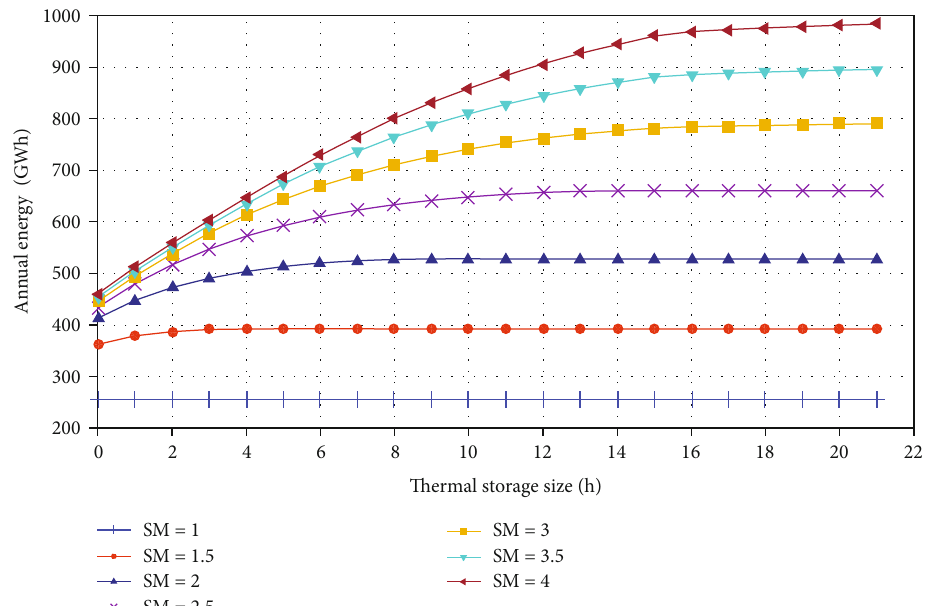
Figure 6: Variation of annual energy with thermal storage size for various SMs.